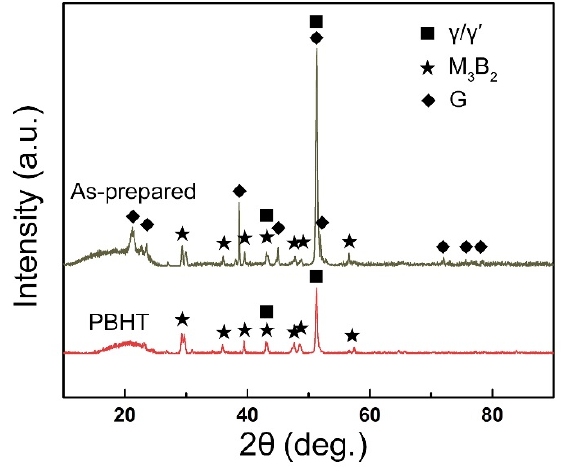
Figure 3. XRD patterns of the as-prepared and PBHT-processed joints.